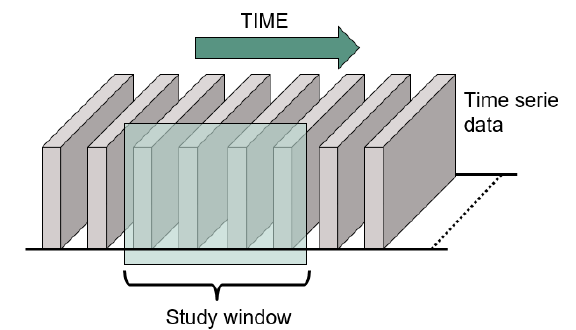
Figure 5. Sliding window used when studying time series with